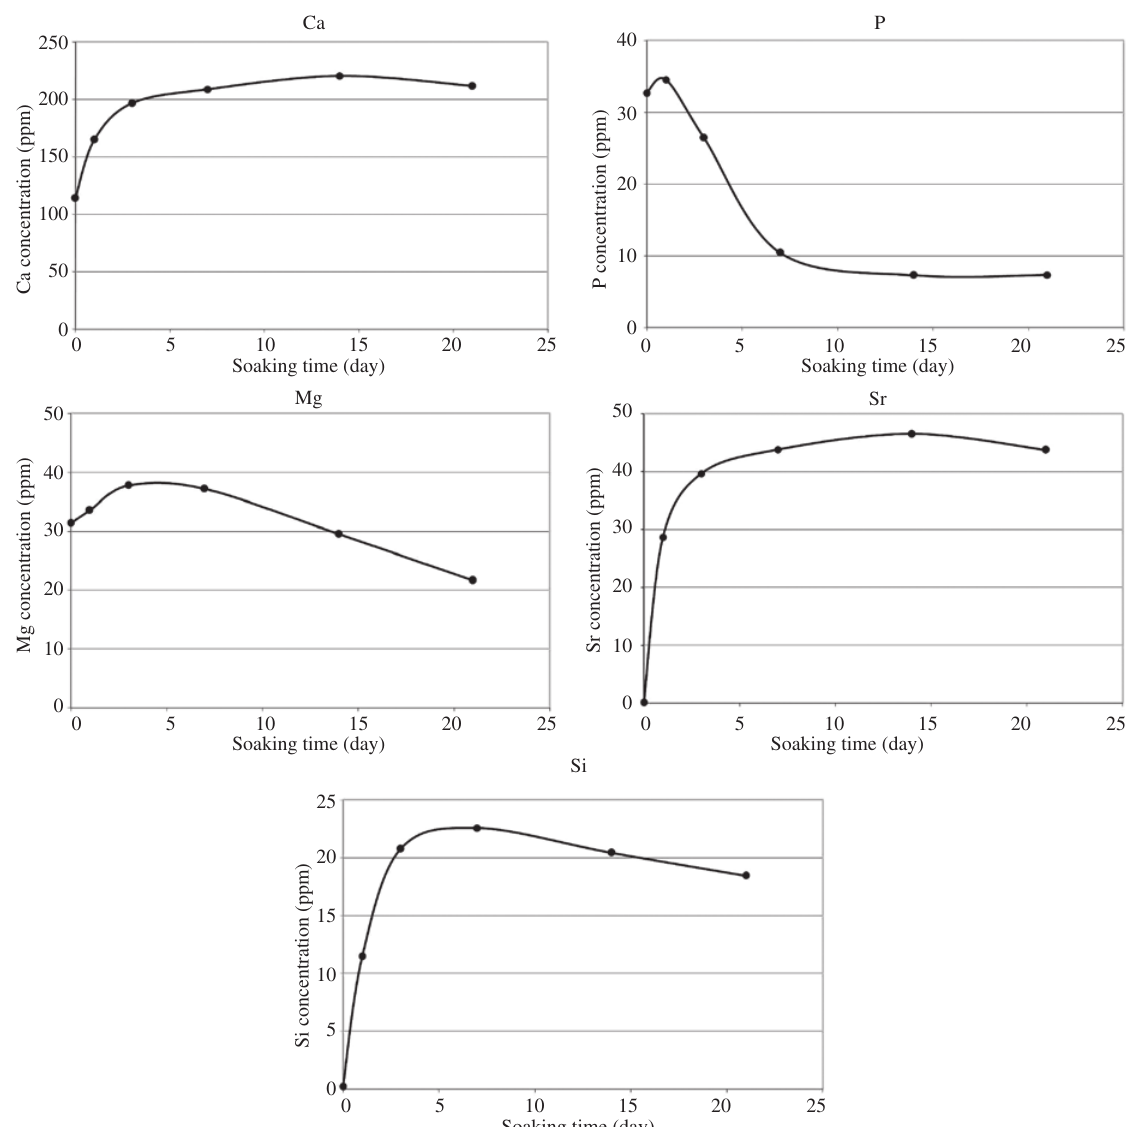
Figure 7 Variation of phosphorus, calcium, strontium, and magnesium concentrations in SBF with immersion